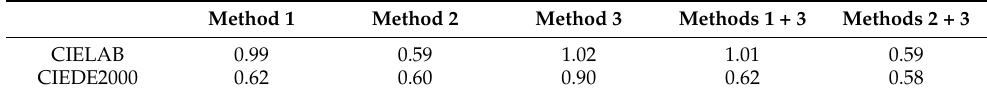
Table 7. The F -test values of the optimized formulas using the 40 sample pairs in Experiment